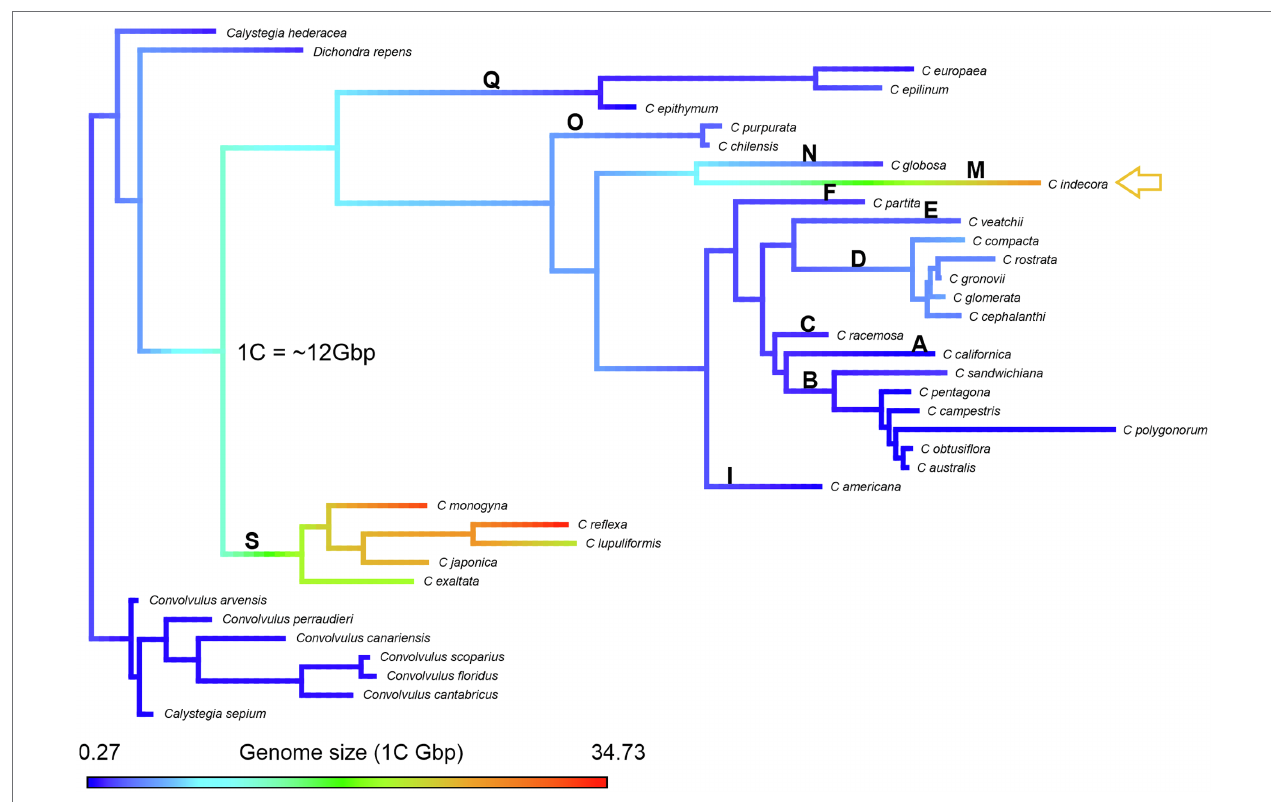
FIGURE 5 | Reconstruction of the genome size evolution via Phytools in R. The variation is shown in a color scale: the largest genomes in shades of red and the smallest genomes in shades of blue. The yellow arrow in the reconstruction indicates C. indecora , a species of the subgenus Grammica in which there was a massive expansion of the genome. The bold letters represent the sections described by García et al. (2014): section S (subgenus Monogynella ), sections R and Q (subgenus Cuscuta ), section P (subgenus Pachystigma ), and sections A–O (subgenus Grammica